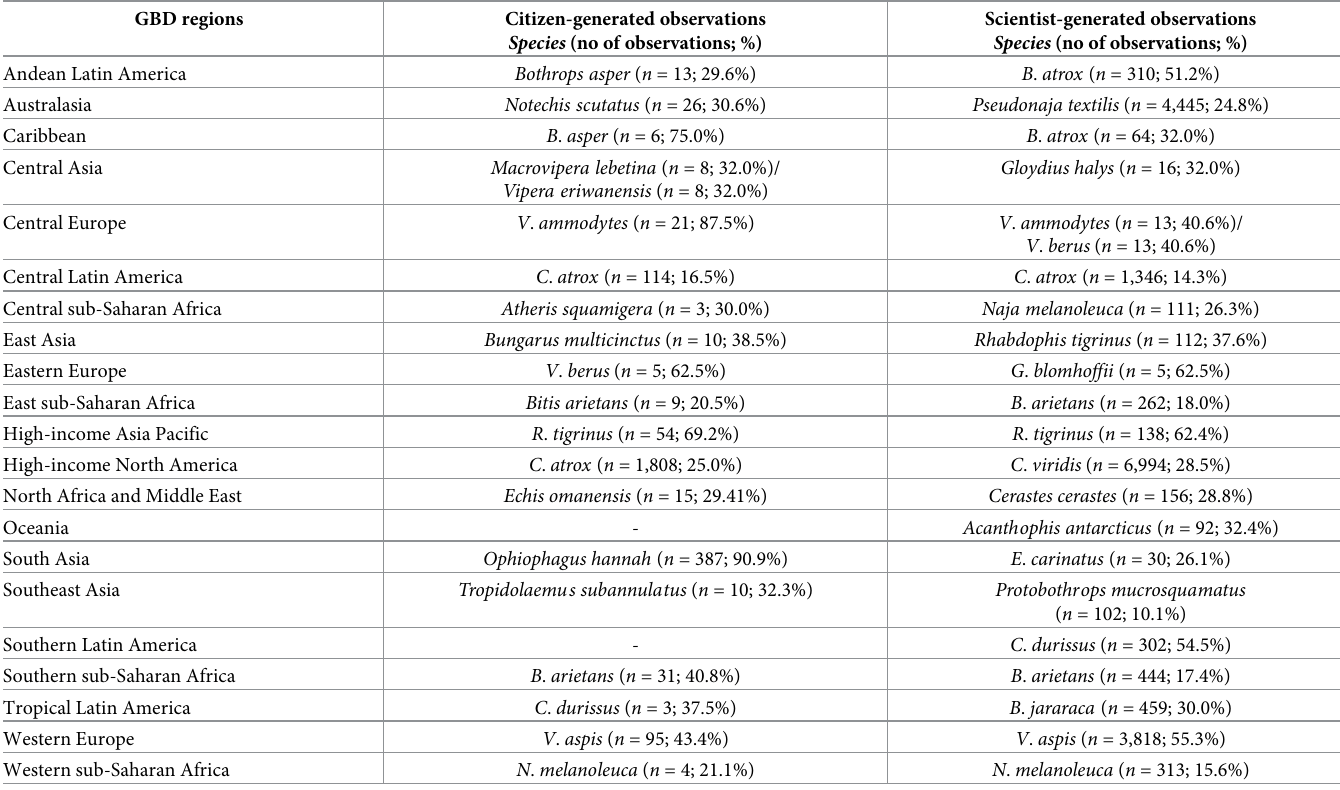
Table 3. Most commonly observed MIVS species in citizen-generated and scientist-generated data sources per GBD